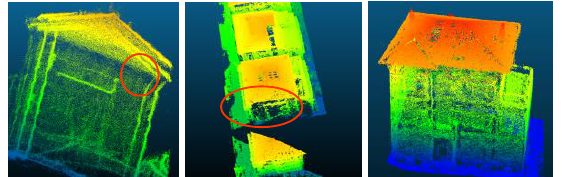
Figure 7. L’Aquila processed point clouds; left: mis-matched walls and roofs before registration; Centre: Missing points in between the walls; Right: Aligned point clouds - thick walls and undefined windows.